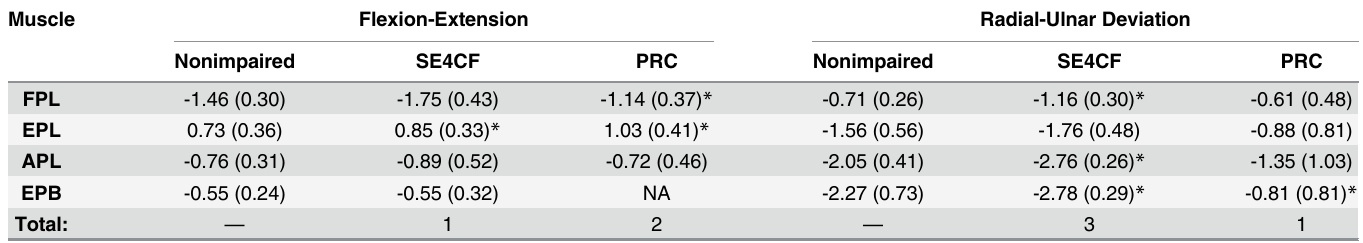
Table 3. Extrinsic Thumb Muscles: Experimentally Measured Wrist Muscle Moment Arms # .